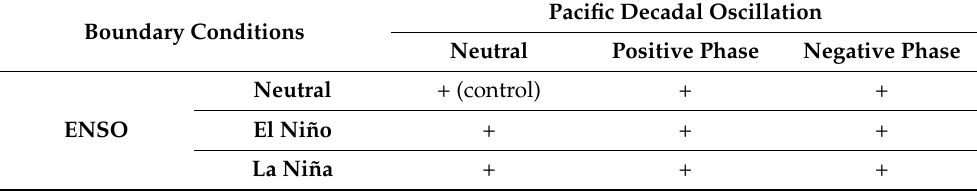
Table 1. Table of